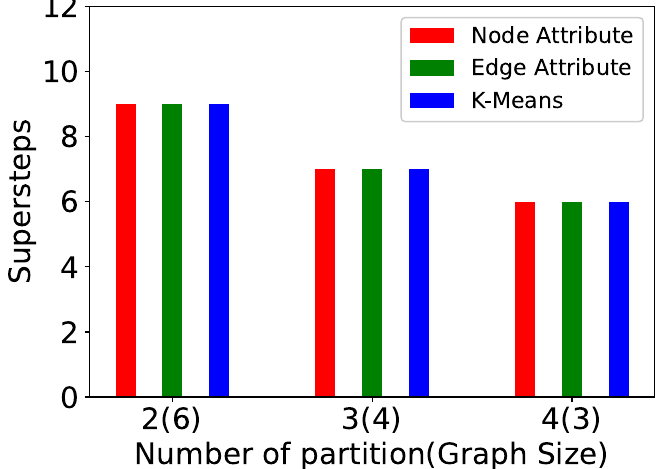
Figure 19. Messages sent for Pg-TSP for a varied number of partitions.